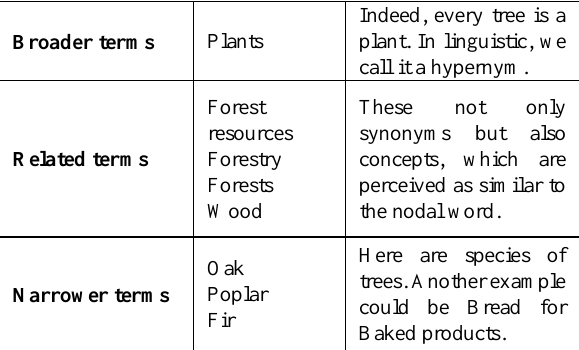
Table 3. Example for tree 4 term in UNESCO